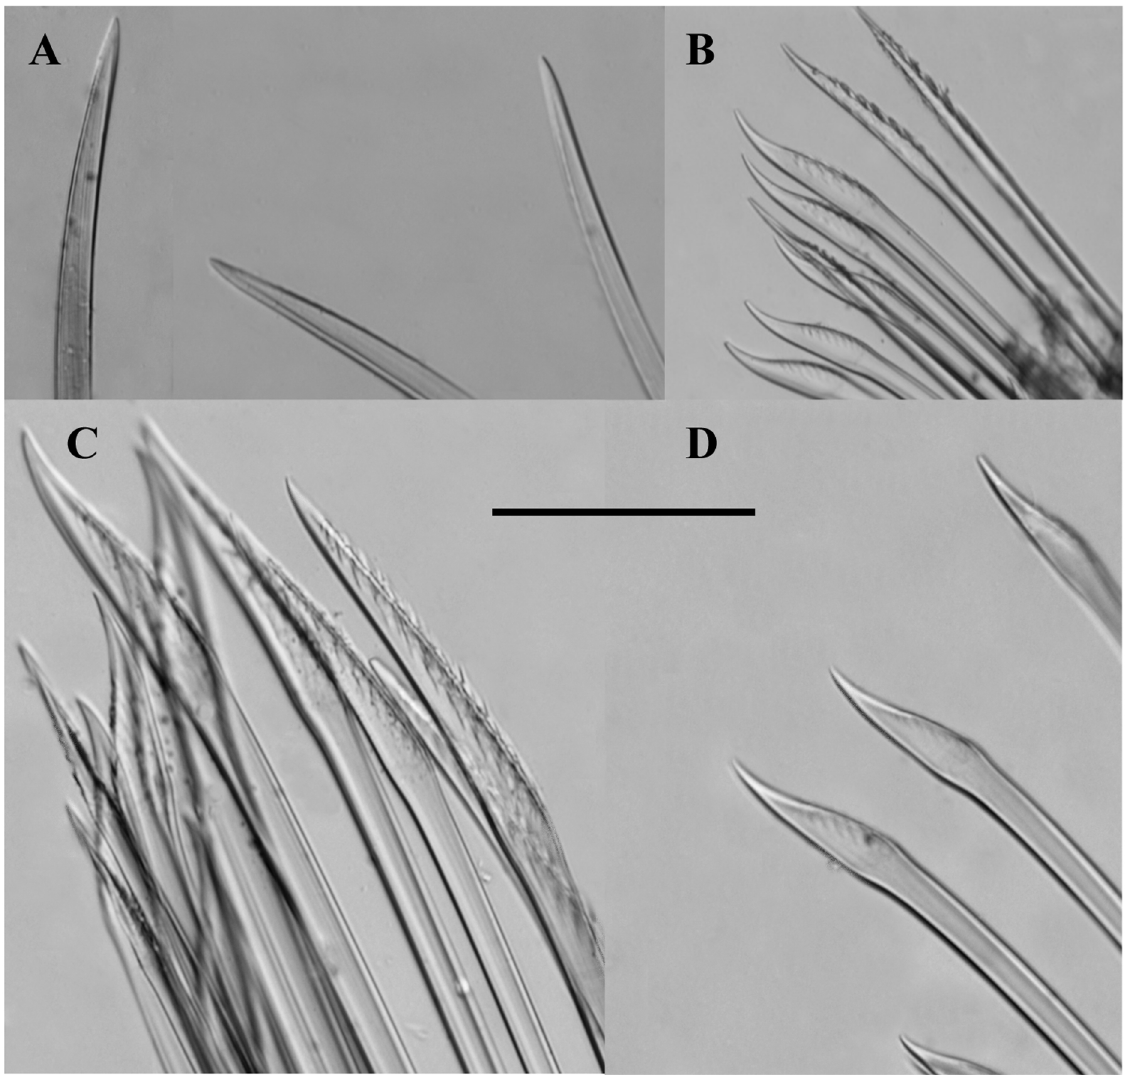
Fig. 6. Webbnesia maculata gen. et sp. nov., holotype (TFMCBM-AN/246). A . Notochaetae. B . Upper, middle and lower neurochaetae. C . Distal part of upper and middle neurochaetae. D . Distal part of